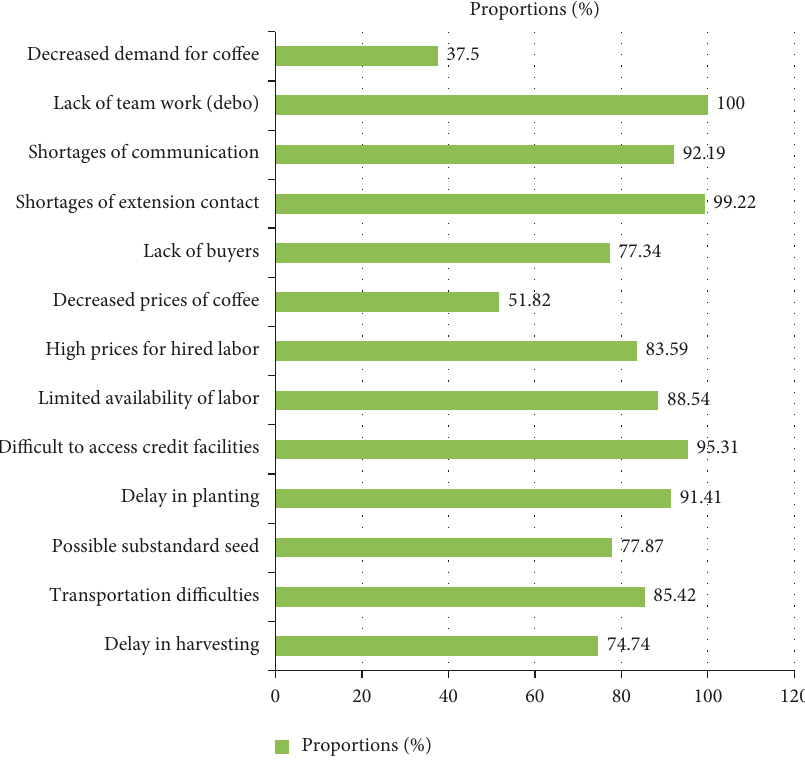
Figure 3: Effects of COVID-19 on farmers’ market participation.